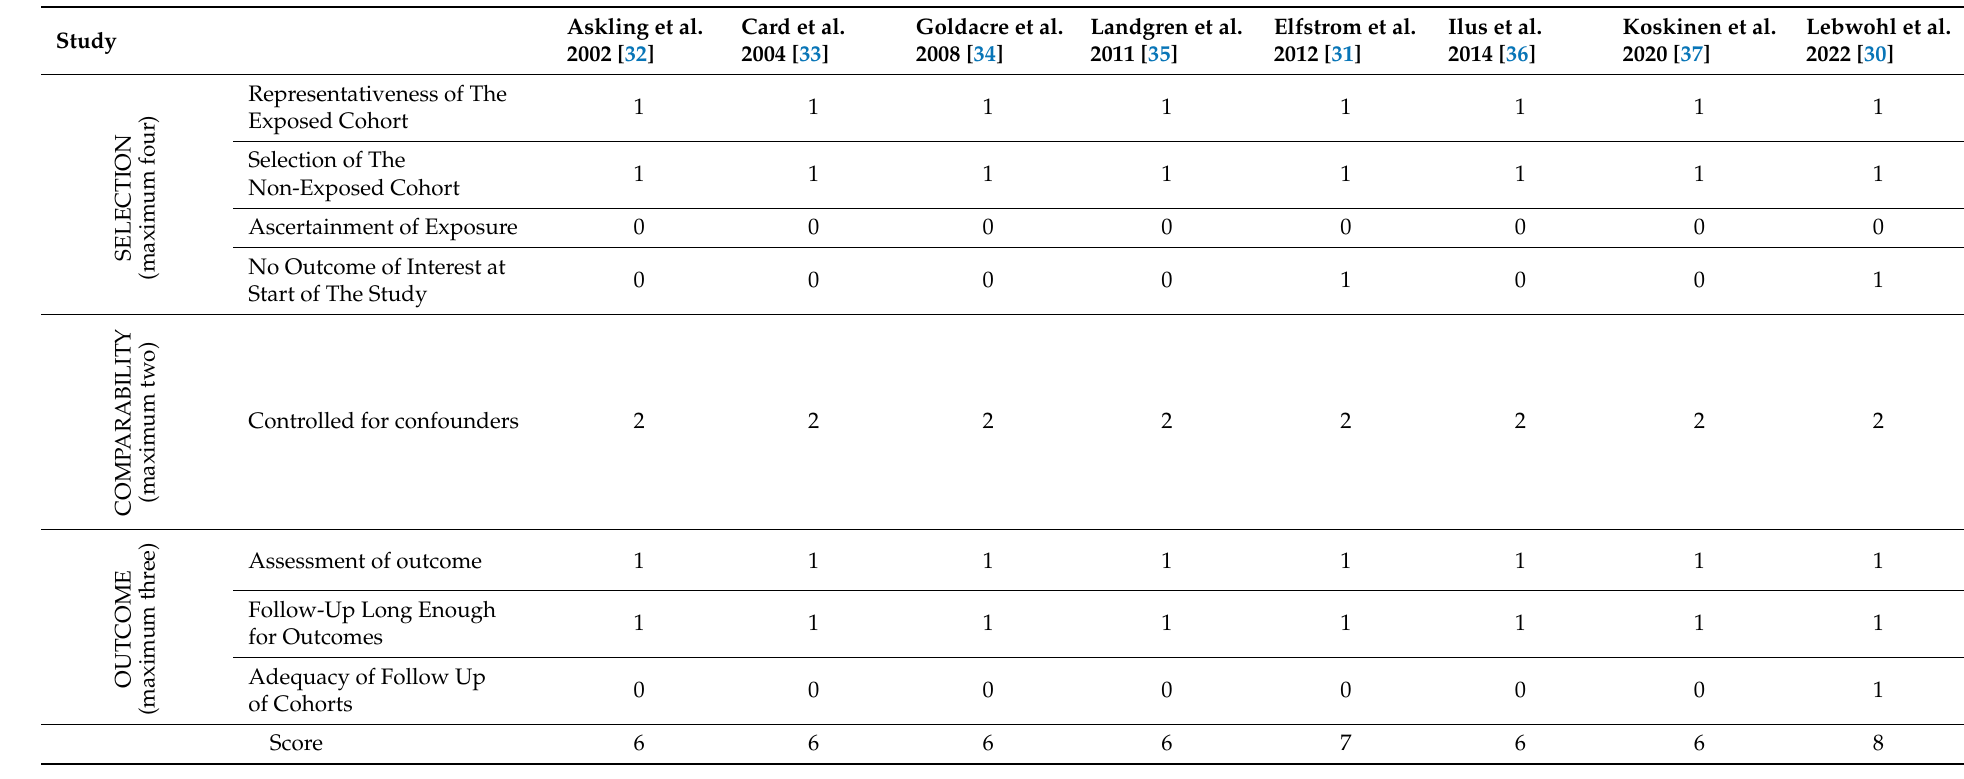
Table 1. Quality assessment of the selected studies using the Newcastle–Ottawa Quality Assessment Scale for cohort